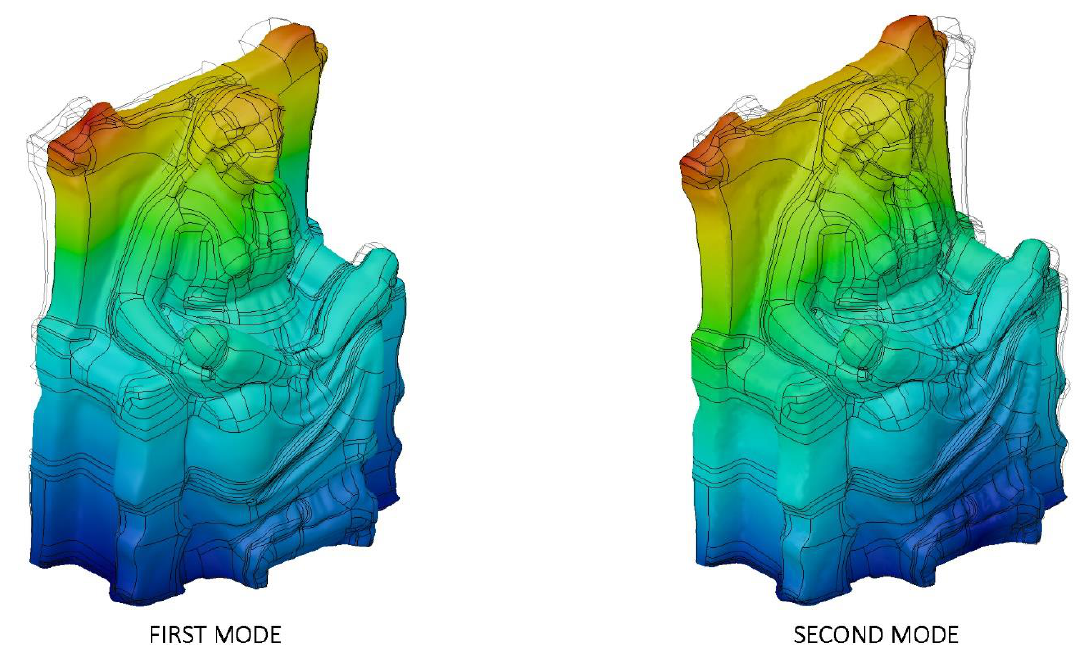
Table 4. Summary of the main geometric features of the asset for seismic rigid block analyses.